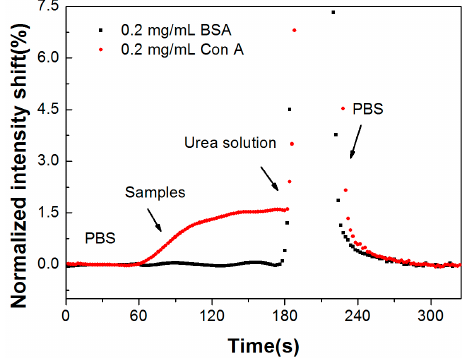
Figure 5. Detection of specific binding between RNase B and Con A and non-specific binding of BSA (bovine serum albumin).